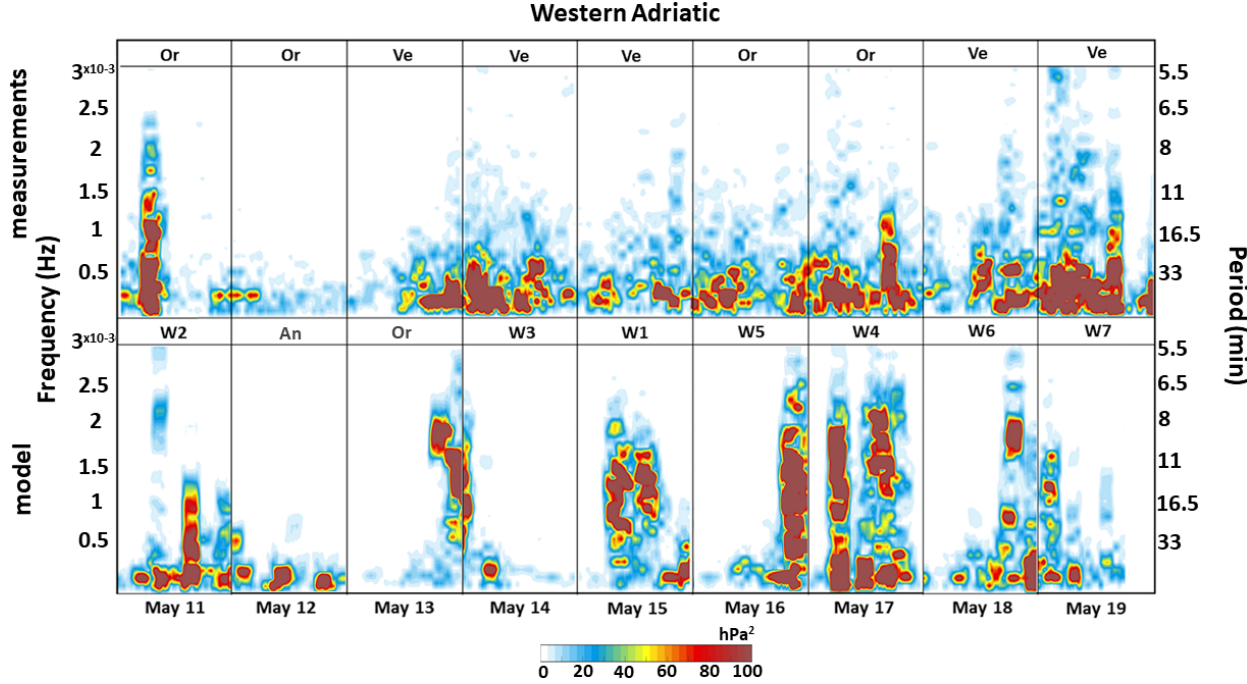
Figure 4. Modelled and measured composites of high-pass-filtered air pressure frequency–time spectrograms for the western Adriatic re- gion. Maximum daily energies measured by the microbarographs (observed composite) and modelled at one WRF 1.5km model grid point (modelled composite) are collocated.